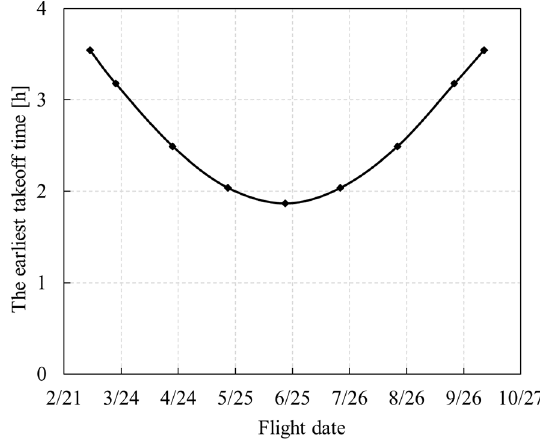
Figure 27. Influence of flight date on the earliest takeoff time.